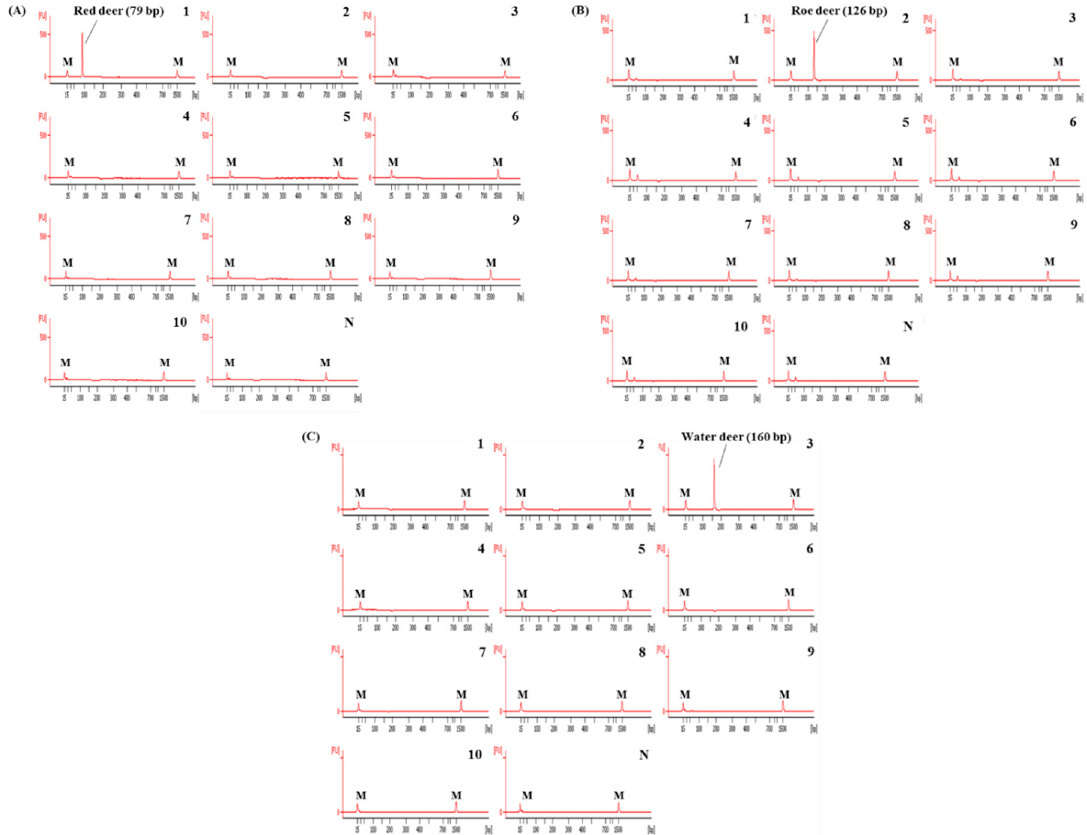
Figure 2. Electropherograms of specificity results of the single PCRs using newly designed primer sets for red deer ( A ), roe deer ( B ), and water deer ( C ). FU: fluorescence, M: alignment marker, lane 1: red deer, 2: roe deer, 3: water deer, 4: beef, 5: pork, 6: lamb, 7: goat, 8: horse, 9: chicken, 10: duck, and N: non-template.